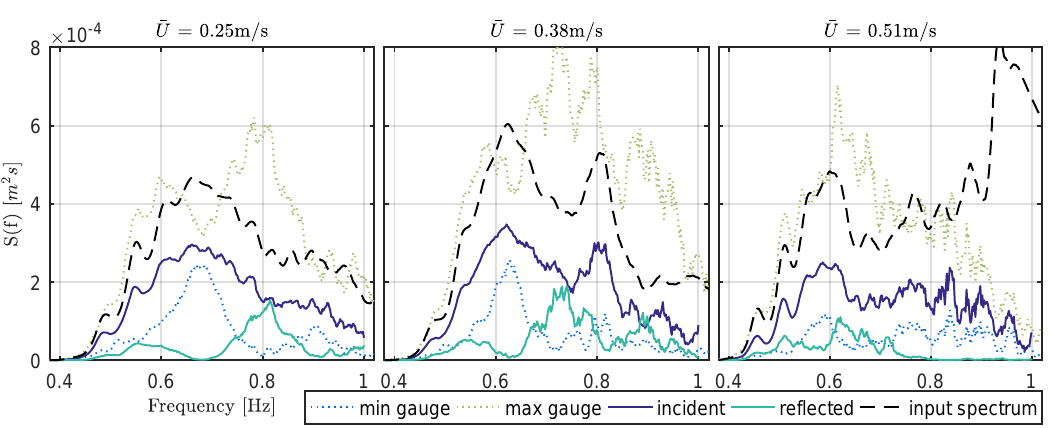
Figure 10. Incident and reflected energy spectra for the irregular wave cases corresponding to Sea States 5–7 in Table 3.